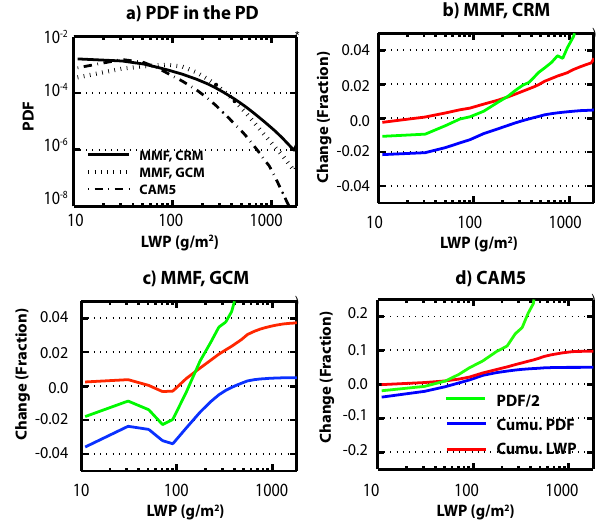
Fig. 17. (a) The PDFs of LWP in the PD simulations in the MMF and CAM5 (solid line is from the in-cloud LWP in CRM columns in the MMF; dotted line is from the in-cloud LWP in GCM columns in the MMF; and dash-dot line is from in-cloud LWP in GCM columns in CAM5); (b–d) relative changes in the PDF of LWP from PI to PD [(PD-PI)/PI] in both the MMF and CAM5. The PDF of LWP are calculated from (b) the in-cloud LWP in CRM columns in MMF, (c) in-cloud LWP in GCM columns in MMF, and (d) in-cloud LWP in GCM columns in CAM5. Green lines are for the relative changes in the PDF of LWP (scaled by a factor of 0.5); blue lines are for the relative changes in the cumulative PDF of LWP; and red lines are for the relative changes in the cumulative LWP. The cumu- lative PDF of LWP (cumu PDF) at a given LWP bin (LWP 0 ) is: 0 cumu PDF= R LWP PDF(LWP)dLWP, where PDF(LWP) is the LWP min PDF of LWP, and LWP min is the smallest LWP bin. The cumulative LWP (cumu LWP) at a given LWP bin (LWP 0 ) is the averaged in- cloud LWP from the smallest LWP bin (LWP min ) to the given LWP R LWP 0 bin: cumu LWP= 1 PDF(LWP) ∗ LWP min cumu PDF